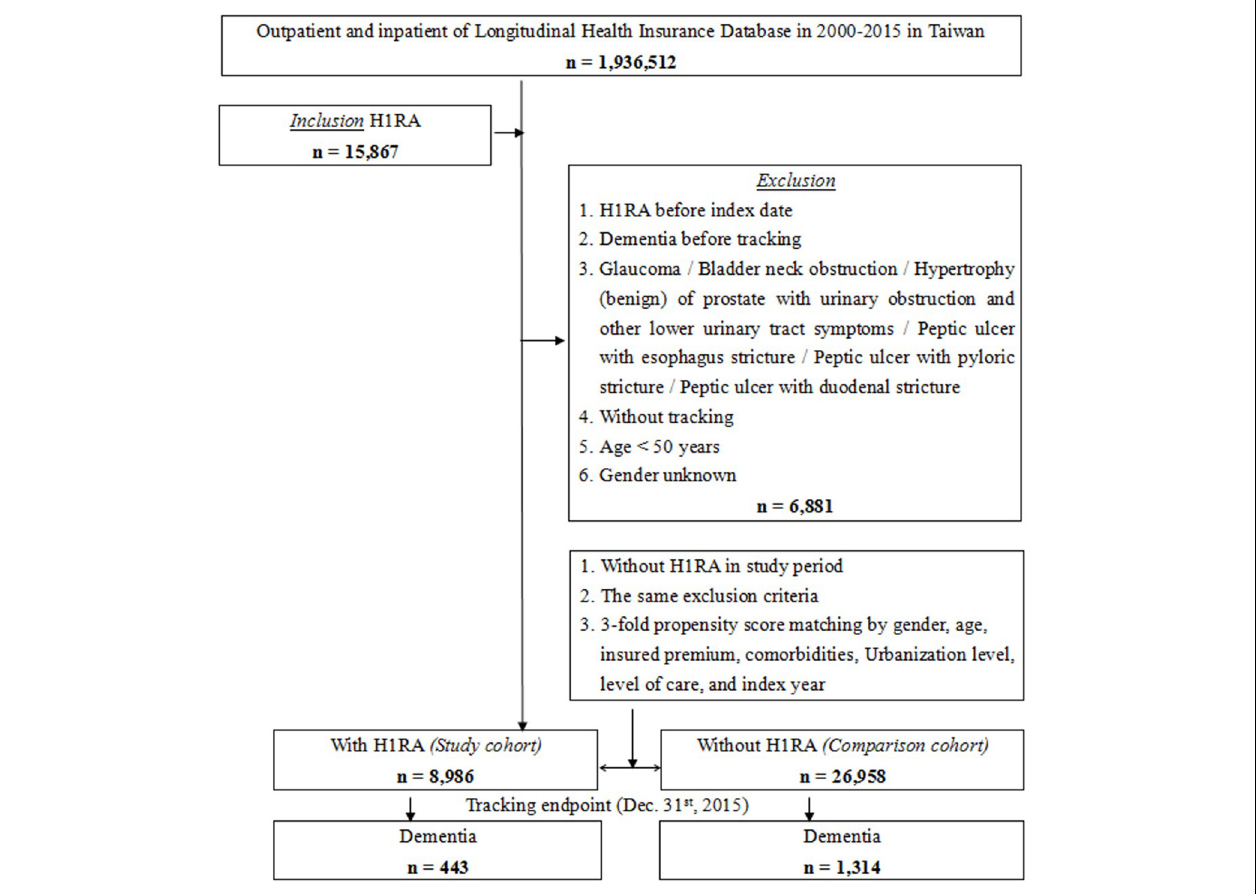
FIGURE 1 | The flowchart of study sample